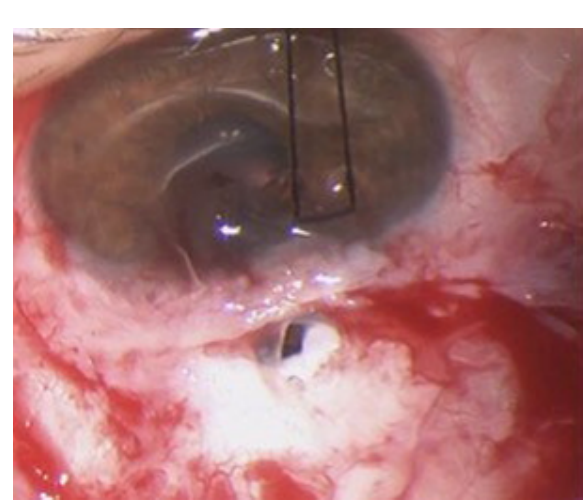
Figure 4: Absence of scleral flap